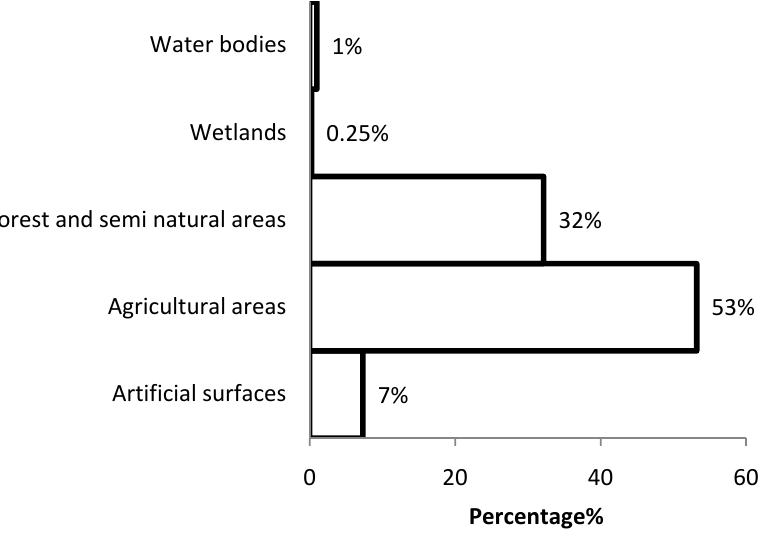
Figure 4. The percentage of the land cover in the study are based on the CORINE land cover.